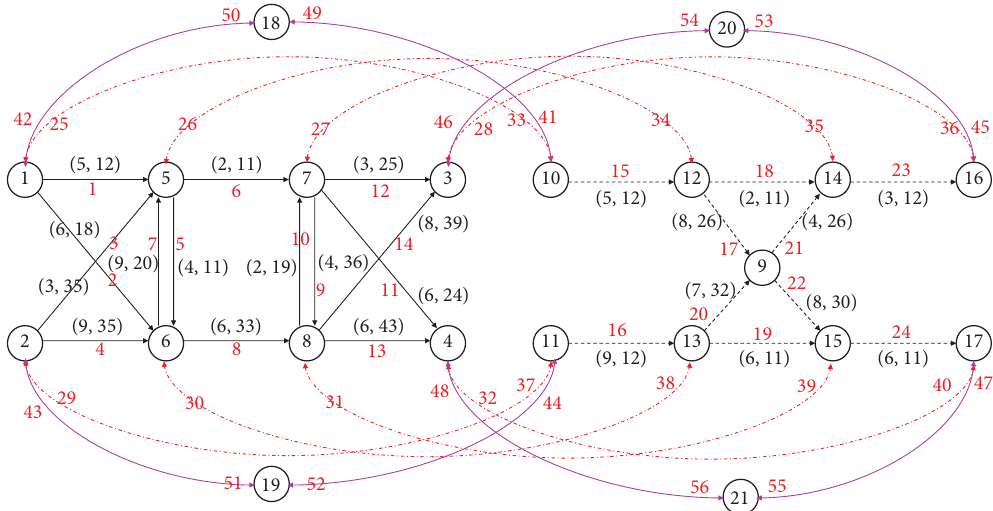
Figure 4: Nine-node network.